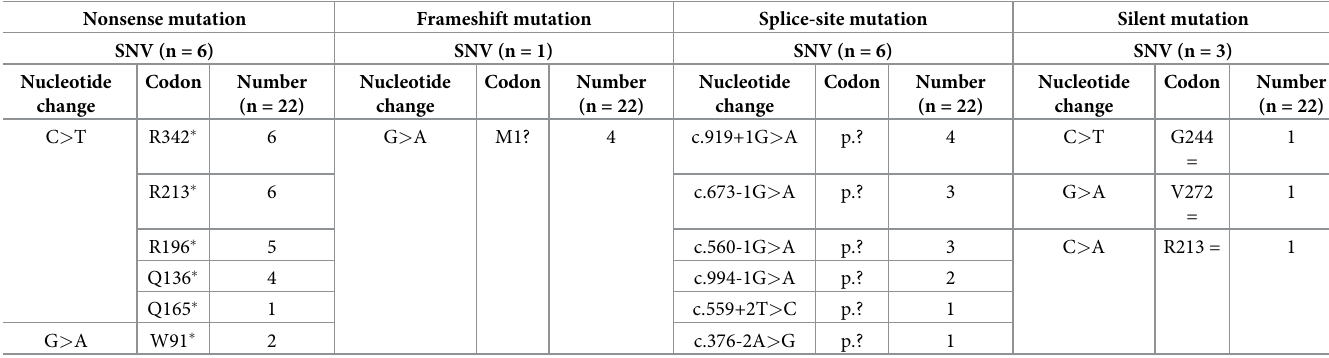
Table 7. TP53 mutation (cont.).